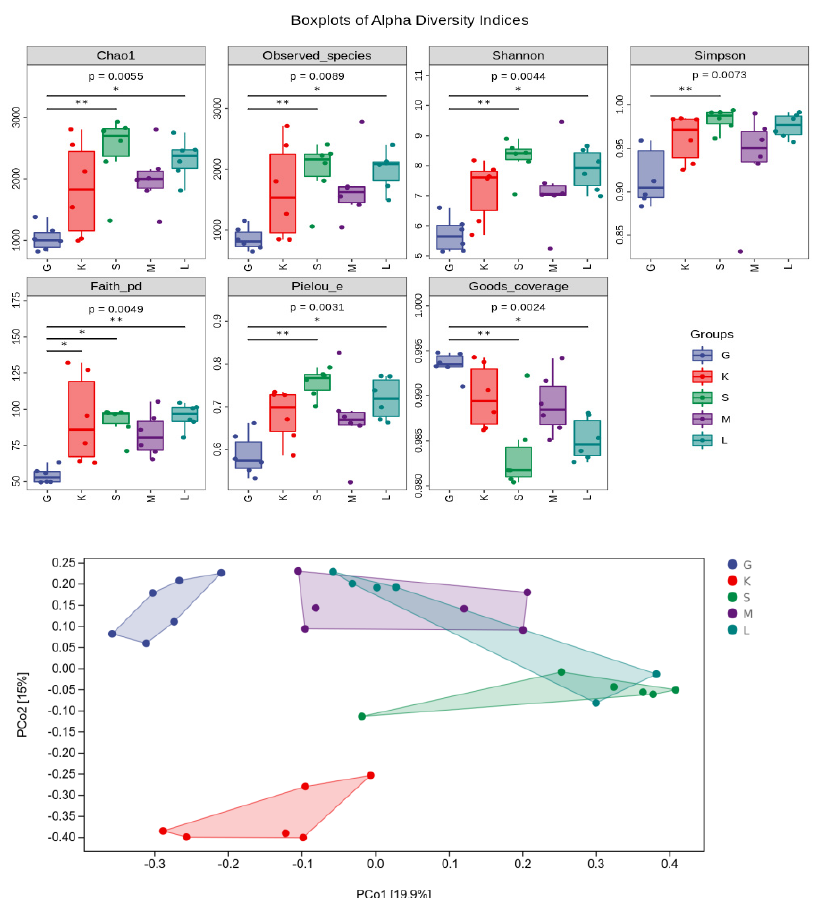
Figure 7. Alpha Diversity Index and Beta diversity PCoA analysis (G: HD group; K: NC group; S: HD-OIDF-10 group; M: HD-OIDF-50 group; L: HD-OIDF-100 group. * represents p < 0.05, ** represents p < 0.01).